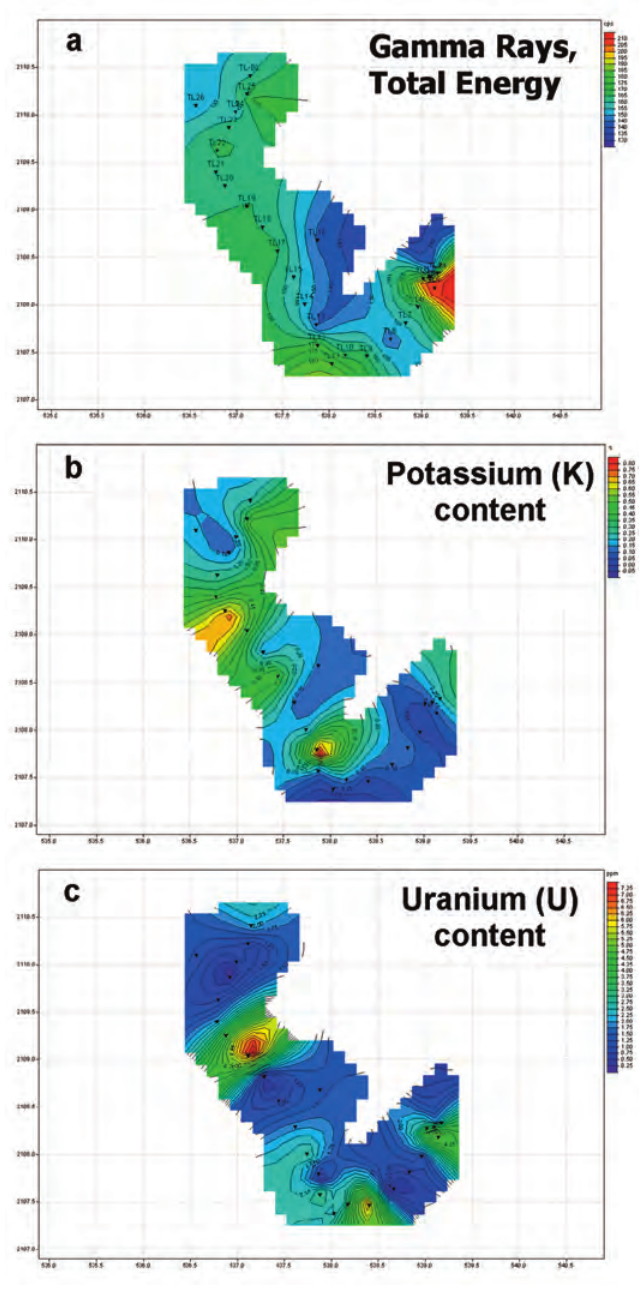
Figure 5a-c. (a) Gamma ray energy (total count above 0.08 MeV); (b) potassium (K; %) content; (c) Uranium (U; ppm)